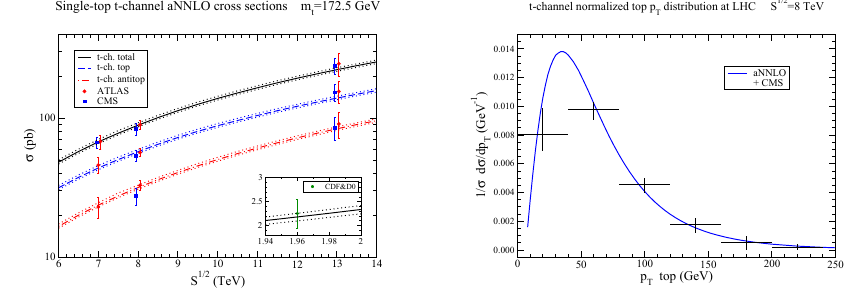
Figure 1. (Left) Single-top t -channel aNNLO cross sections compared with CMS and ATLAS data at 7 TeV [12, 13], 8 TeV [14, 15], and 13 TeV [16, 17], and with CDF and D0 combined data at 1.96 TeV [18]. (Right) Top-quark aNNLO normalized p T distributions in t -channel production at 8 TeV compared to CMS [19] data.